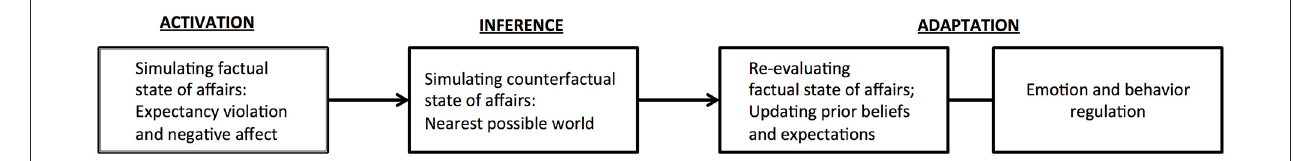
FIGURE 1 | Stages of counterfactual reasoning: a schematic